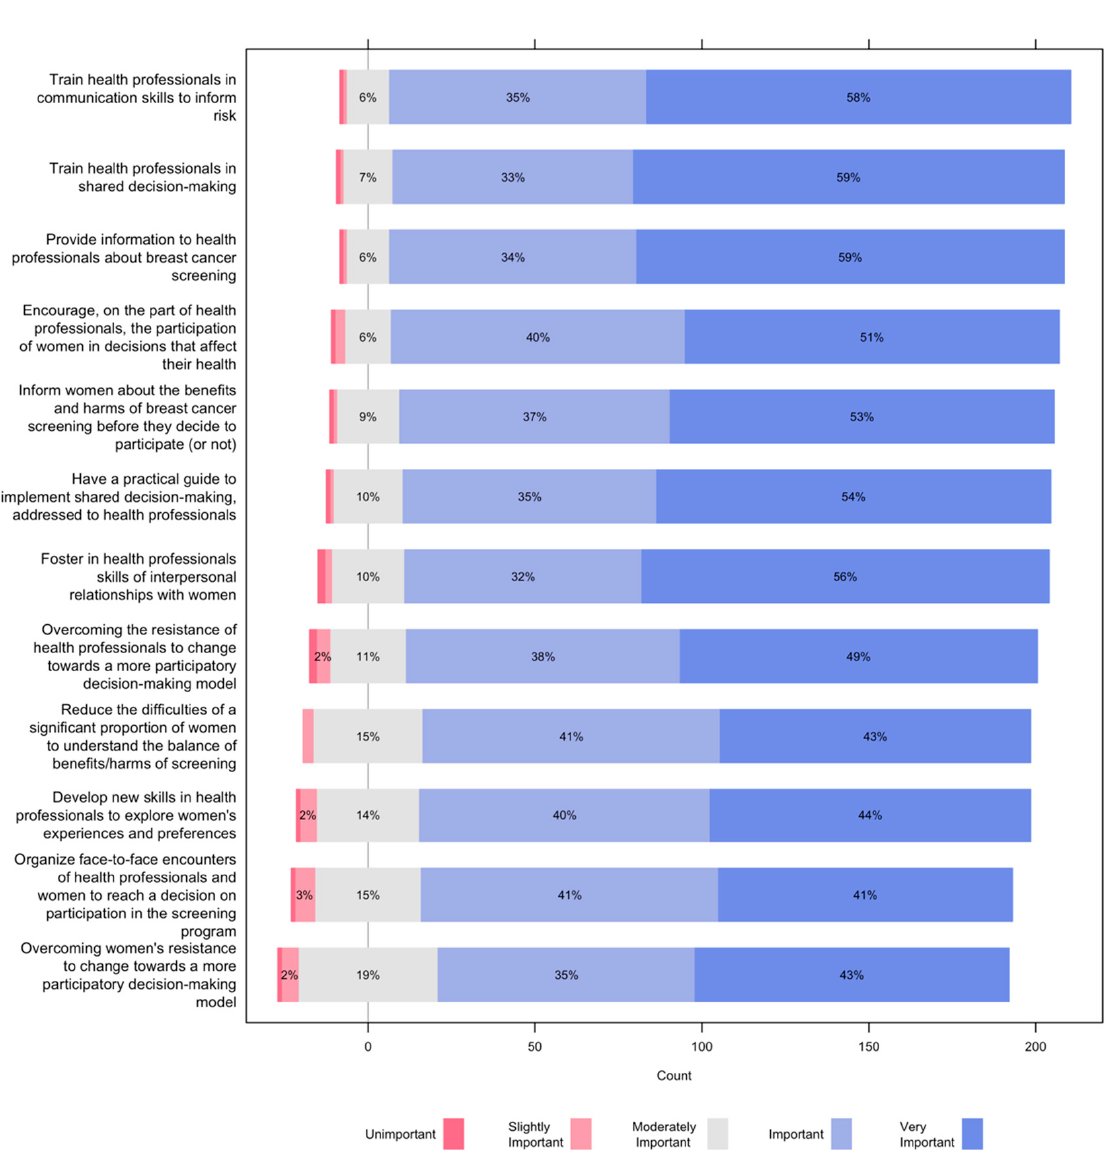
Figure 6. Views of health professionals on the implementation of shared decision-making in breast cancer screening.